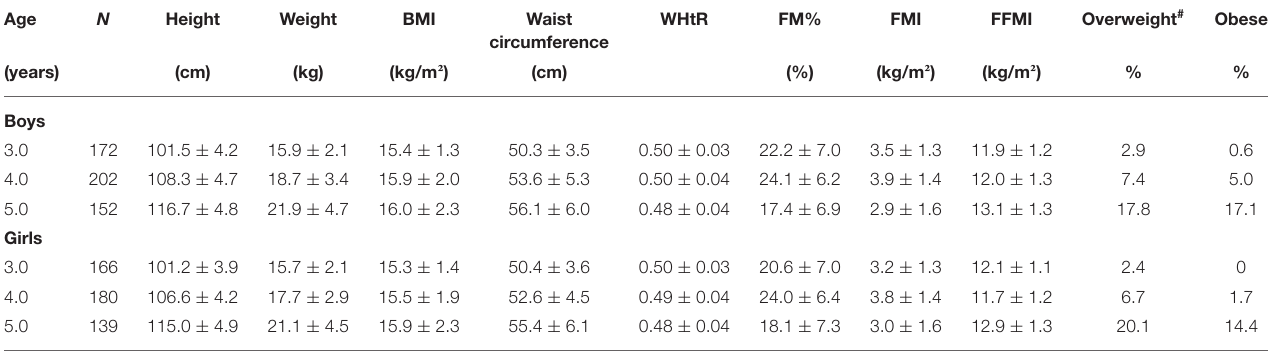
WHtR FM% FMI FFMI Overweight # Obese circumference (kg/m ² ) % %